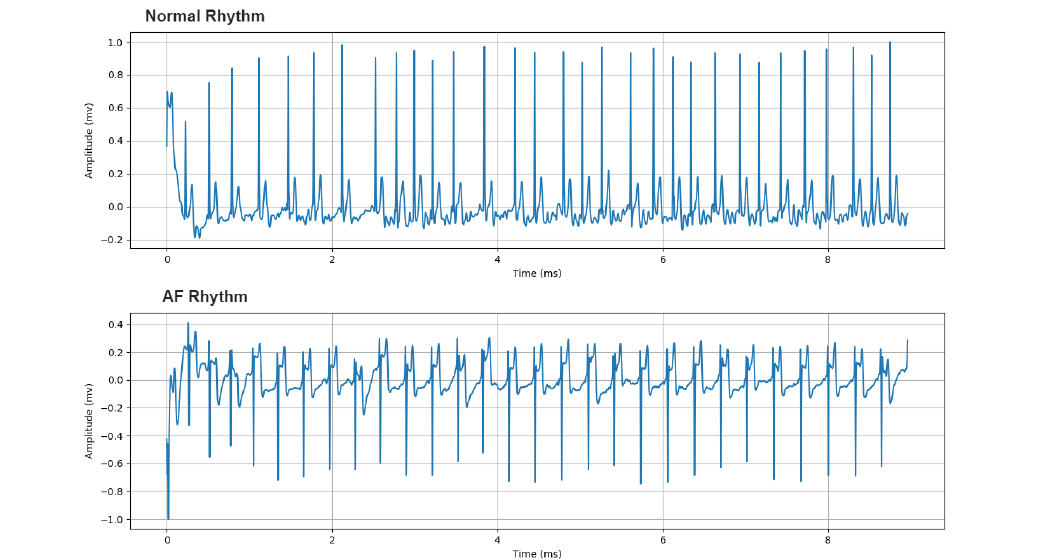
Figure 1. Samples of 1 lead electrocardiogram (ECG) records contained in the dataset of the 2017 Computing in Cardiology Challenge (https://www.physionet.org/content/challenge-2017/1.0.0/). From top to bottom, ECG with Normal Rhythm and Atrial